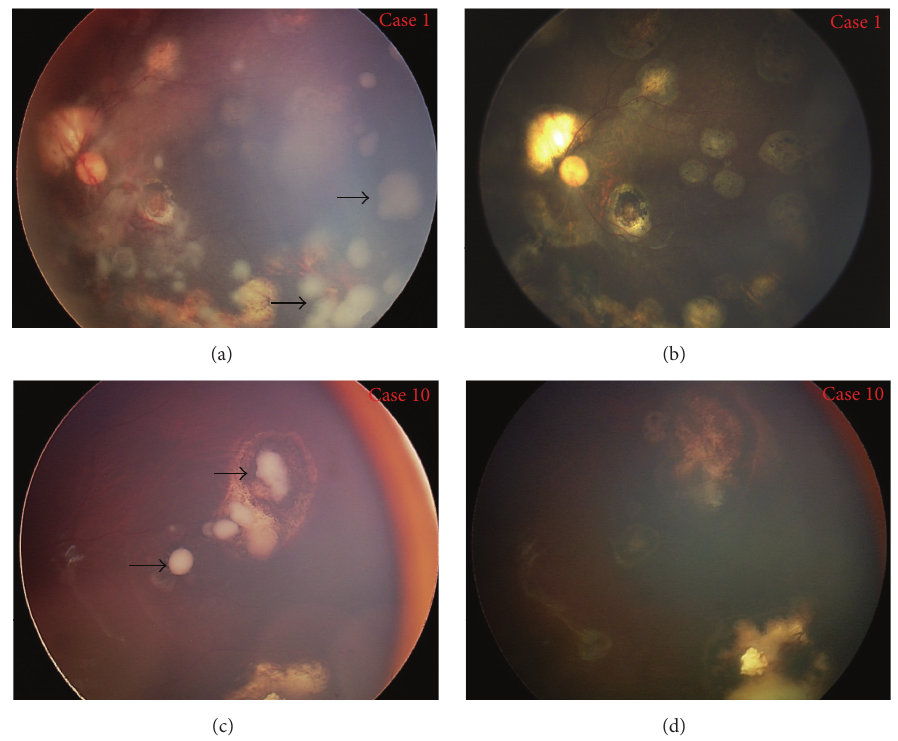
Figure 2: Control of recurrent seeds in case 1 (upper) and case 10 (lower). (a) Extensive spheres vitreous seeds (arrow) were noted after 6 IVC, 1 OAC, and focal consolidation in case 1. (c) Localised spheres vitreous seeds (arrow) were noted after 5 IVC and focal consolidation in case 10. (b) and (d) After intravitreal melphalan, vitreous seeds in both cases regressed into type